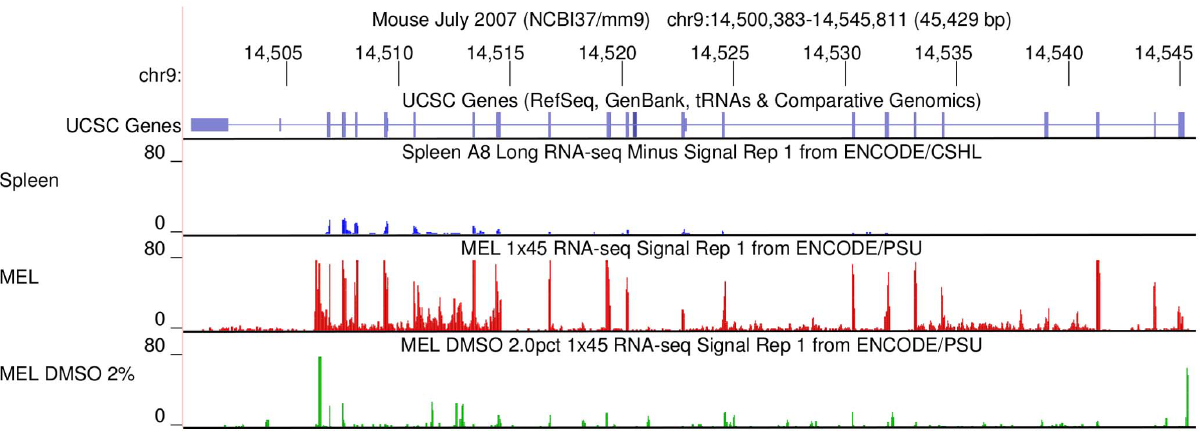
Figure 1. Expression of MIWI2 in spleen and MEL cells. The top track shows the MIWI2 (PIWIL4) gene, as depicted by the UCSC Genes track on the UCSC Genome Browser [21]. The gene itself is depicted in purple and its position on chromosome 9 in shown. Note the 3 9 untranslated region at the far left. Below are ENCODE [22] data tracks representing RNA-seq signals from adult spleen (blue), uninduced MEL cells (red) and MEL cells induced with 2% DMSO (green). Uninduced MEL cells show a relatively strong signal for MIWI2 when compared to the low – but present – signal in